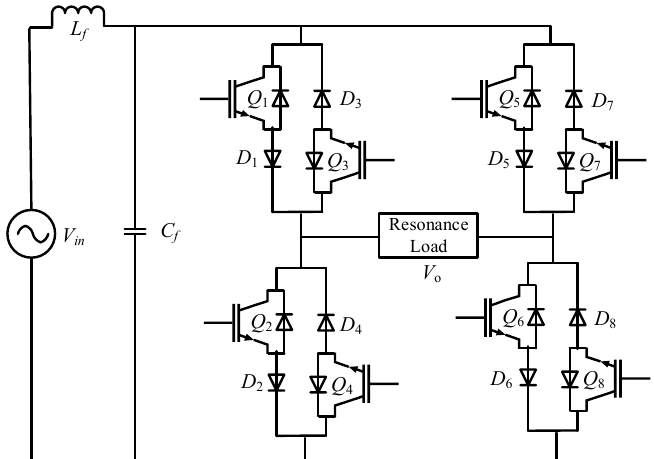
Figure 1. Dual bridge direct ac-ac converter.